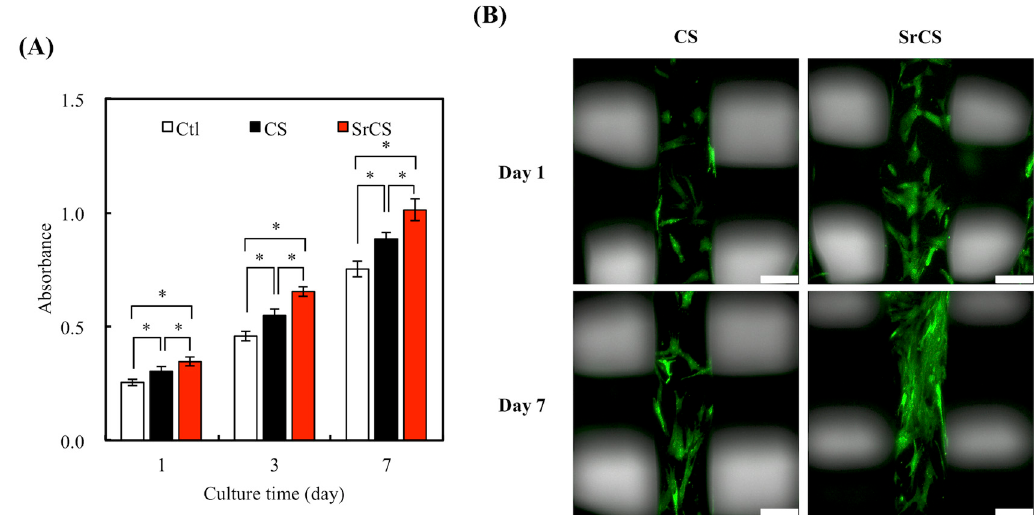
Figure 8. ( A ) Proliferation of MSCs on CS and SrCS scaffolds for different durations and ( B ) F-actin immunofluorescence stains. Data presented as mean ± SEM, n = 6 for each group. “*” indicates a significant difference ( p < 0.05) between two groups. “Ctl” represented cells that grew in empty wells without any scaffolds. Scale bar: 250 µm.